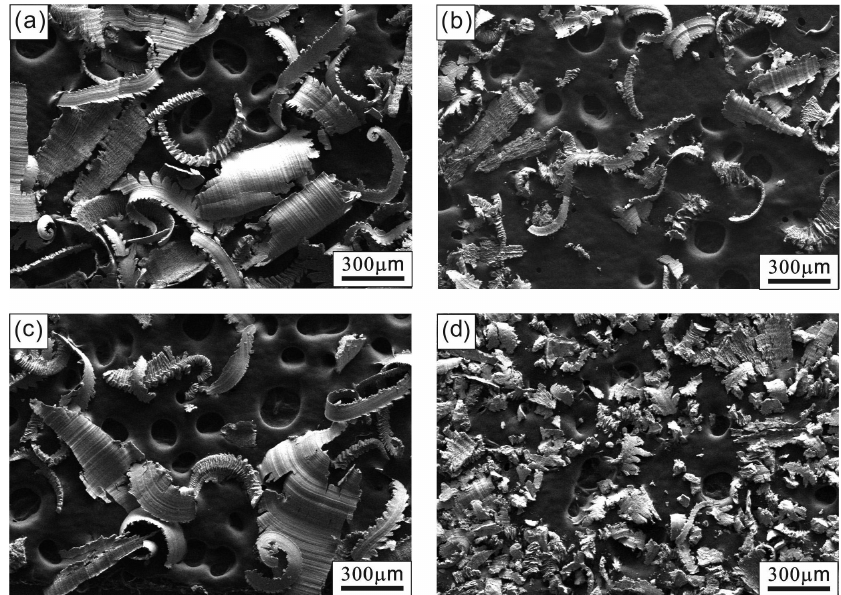
Figure 9. Metal chips cut from Ti15Sn x Cu samples: (a) AS Ti15Sn, (b) HT Ti15Sn, (c) AS Ti15Sn2Cu and (d) HT